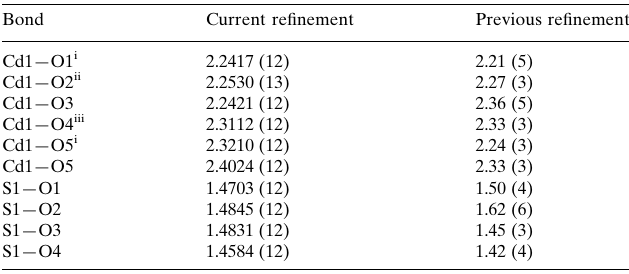
Comparison of bond lengths (A˚ ) in the current and the previous (Bregeault & Herpin, 1970) refinement of cadmium sulfate monohydrate. For the previous refinement: a = 7.607, b = 7.541, c = 8.186 A˚ , (cid:3) = 121.86 (cid:3) and reliability index R = 0.12.